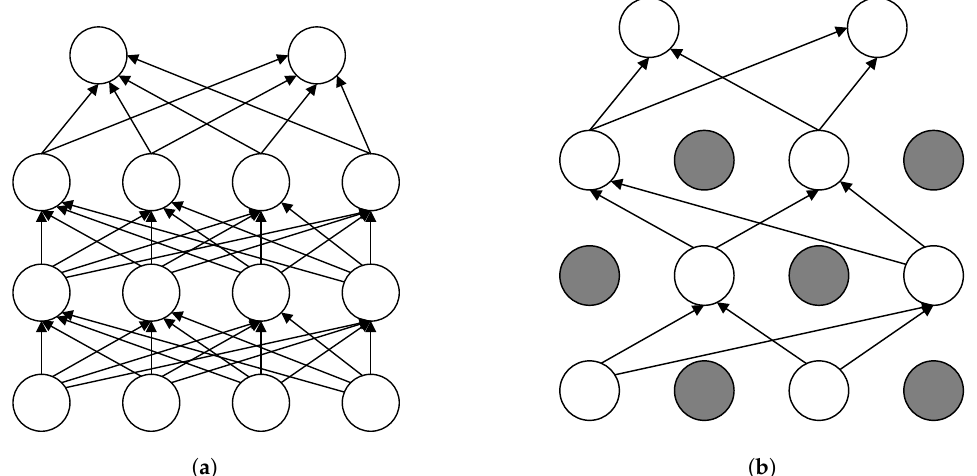
Figure 1. Dropout neural network model: ( a ) standard neural network; and ( b ) neural network with